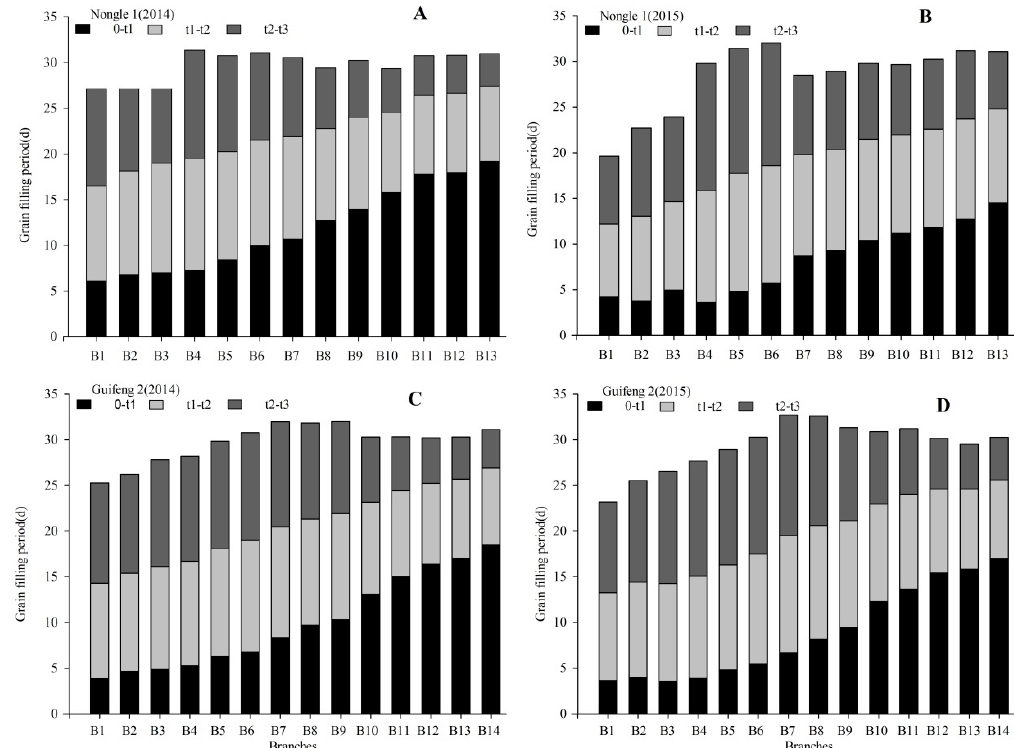
Figure 5. The period for the beginning (0- t 1 ), middle ( t 1 - t 2 ) and end ( t 2 - t 3 ) of grain filling of primary-branch grains at different positions for Nongle 1 ( A , B ) and Guifeng 2 ( C , D ) in 2014 and 2015. B1 to B14 represent the 1st primary-branch grains to the 14th primary-branch grains from the top to the base of the panicle for Nongle 1 and Guifeng 2. 0- t 1 , t 1 - t 2 and t 2 - t 3 represent the period with gradual, fast, slow dry matter accumulation, respectively.